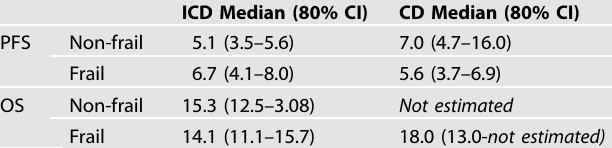
Fig. 3 Overall survival. Table 3. Median survival estimates (months) by treatment and frailty group.